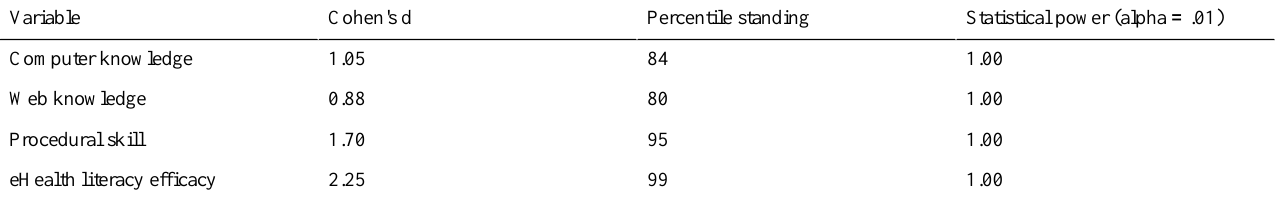
Table 5. Effect sizes and statistical